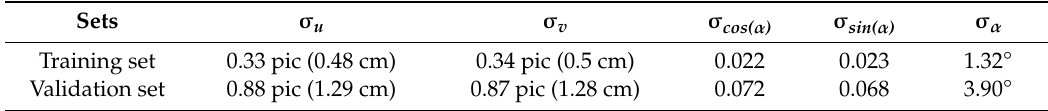
Table 2. Error of coordinates and rotation angle for the ground robot for navigation by the di ff usion map; size of the robot is 50 cm × 50 cm; pixel size corresponds to 1.47 cm on the ground.